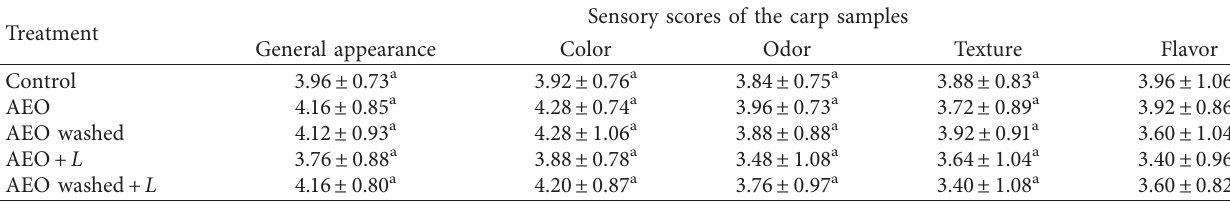
Sensory scores of the carp